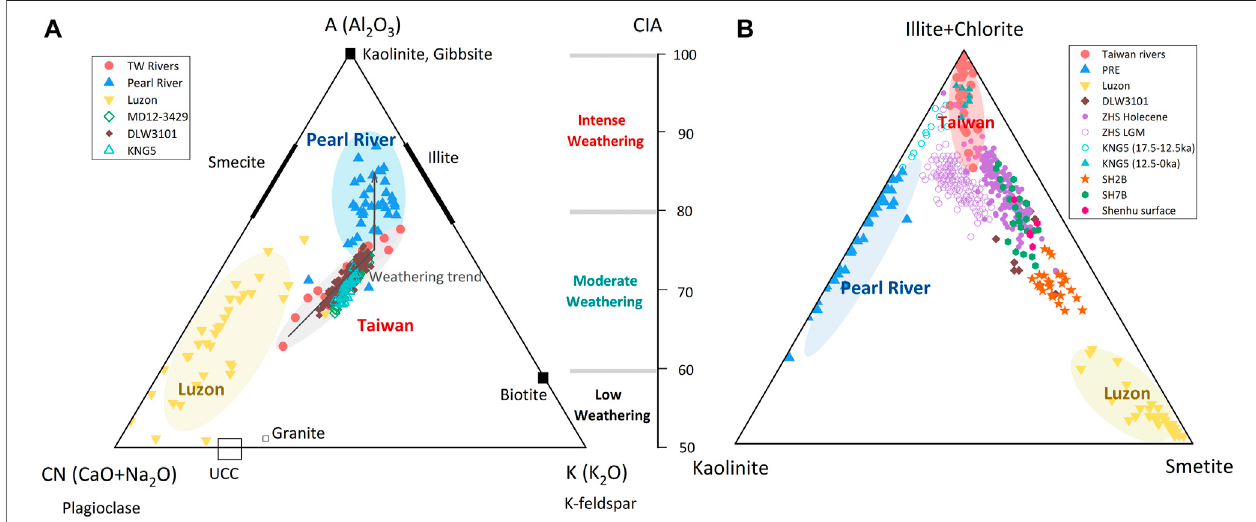
FIGURE 6 | Compilation of major element composition (A) and clay mineral proportion (B) of sediments from the Shenhu area, SCS. Data of the Shenhu surface sedimentfromXuW.etal.(2014);SH2BandSH7BfromLuetal.(2009);DLW3101fromHuetal.(2021);ZHS176fromGeetal.(2010)andHuetal.(2021);KNG5from Huang et al. (2011), Huang et al. (2016), and Liu et al. (2017); and MD12-3429 from Hu et al. (2021).